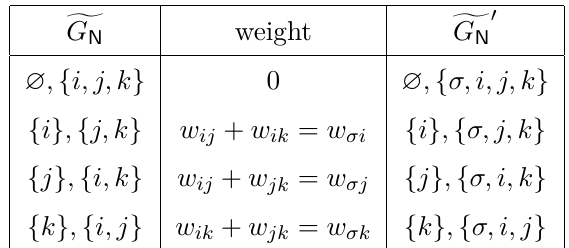
0 , depending on exactly